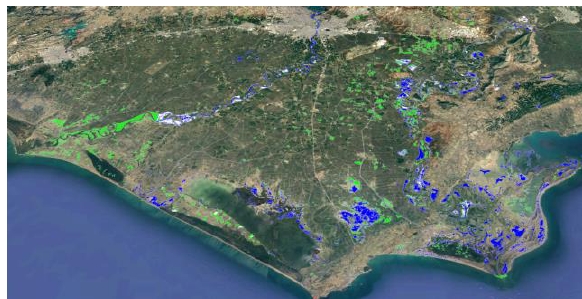
Figure 10. SPOT-6 vs SAR result